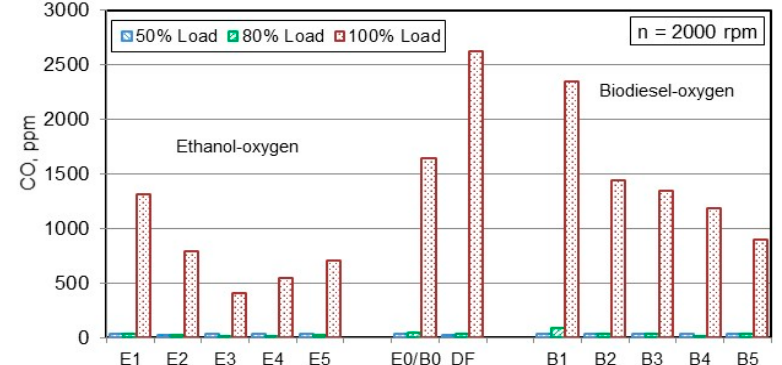
Figure 15. Effect of ethanol–oxygen or biodiesel-oxygen mass content (wt%) in fuel blends on the CO production when running under medium (50%), intermediate (80%), and full (100%) loads corresponding to the respective IMEPs of 0.75, 1.20, and 1.50 MPa, developed at maximum torque speed of 2000 rpm.